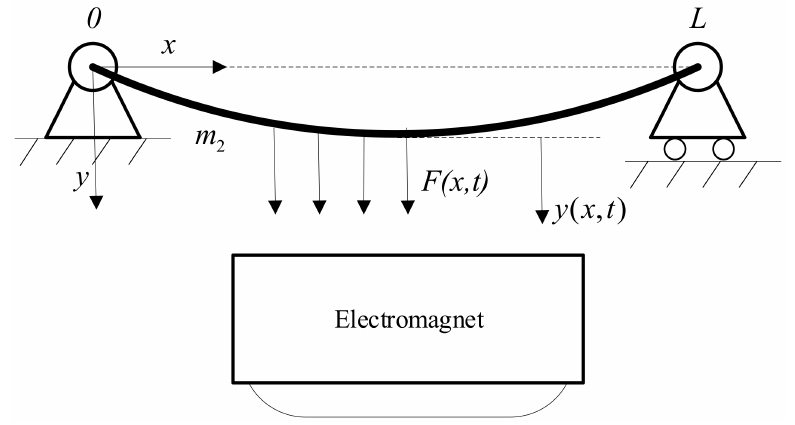
Figure 2. Simplified model of the maglev vehicle–guideway coupled